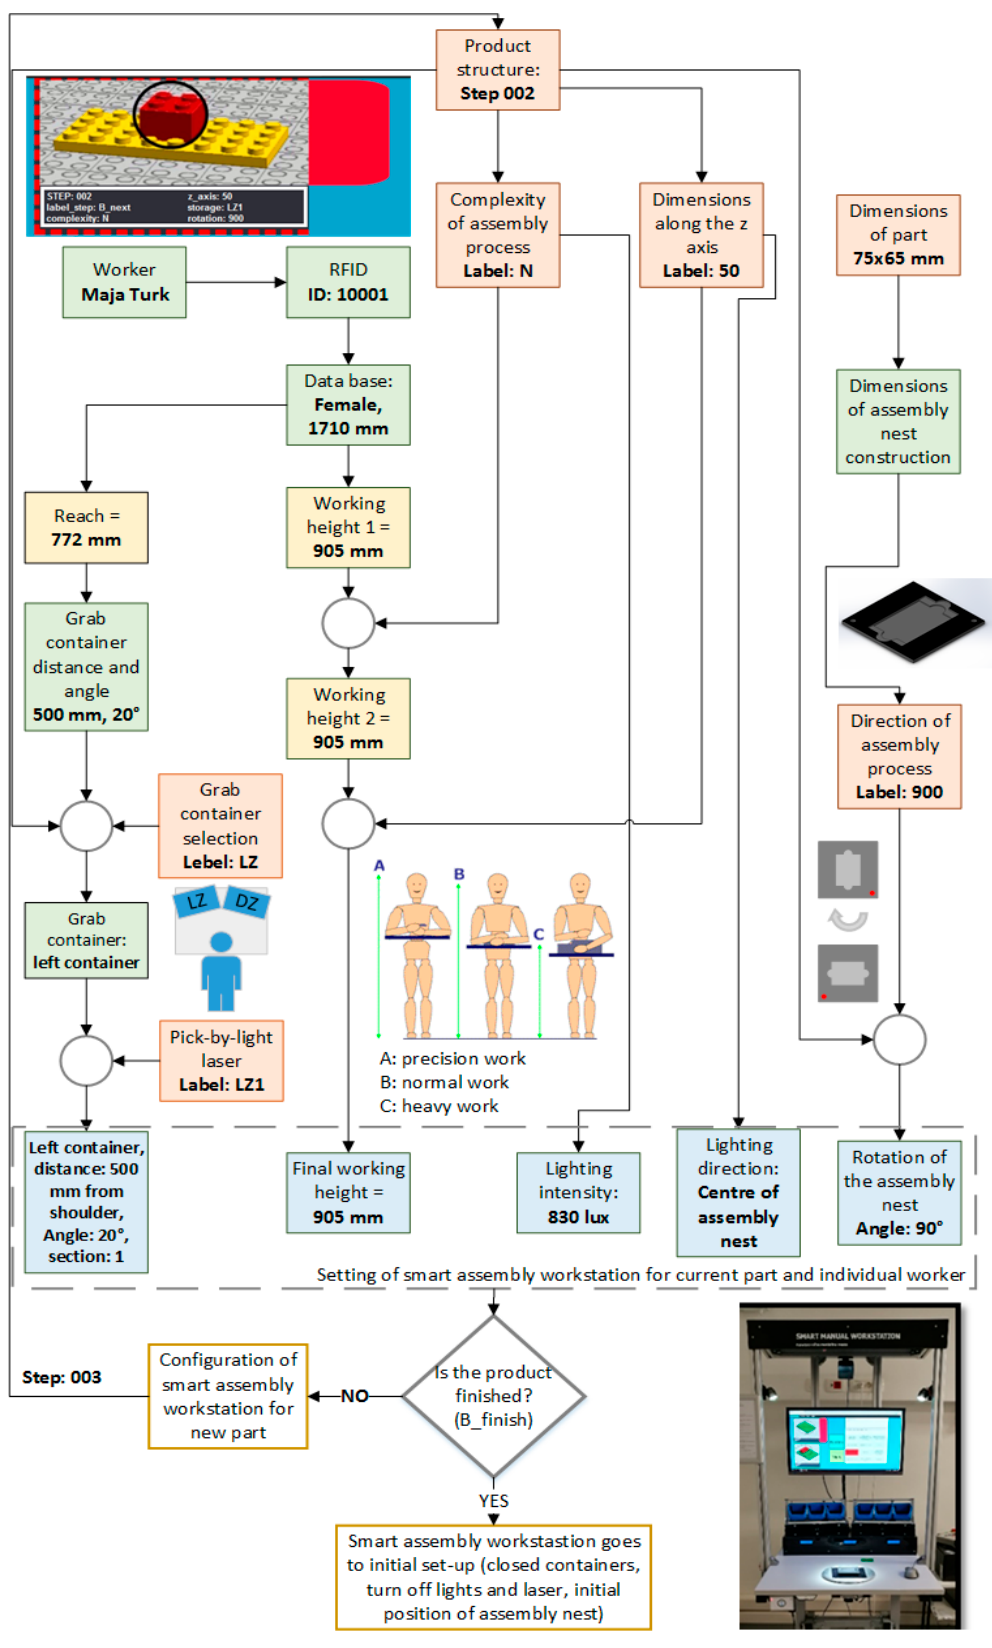
Figure 9. Block diagram of a smart algorithm for step number 002.